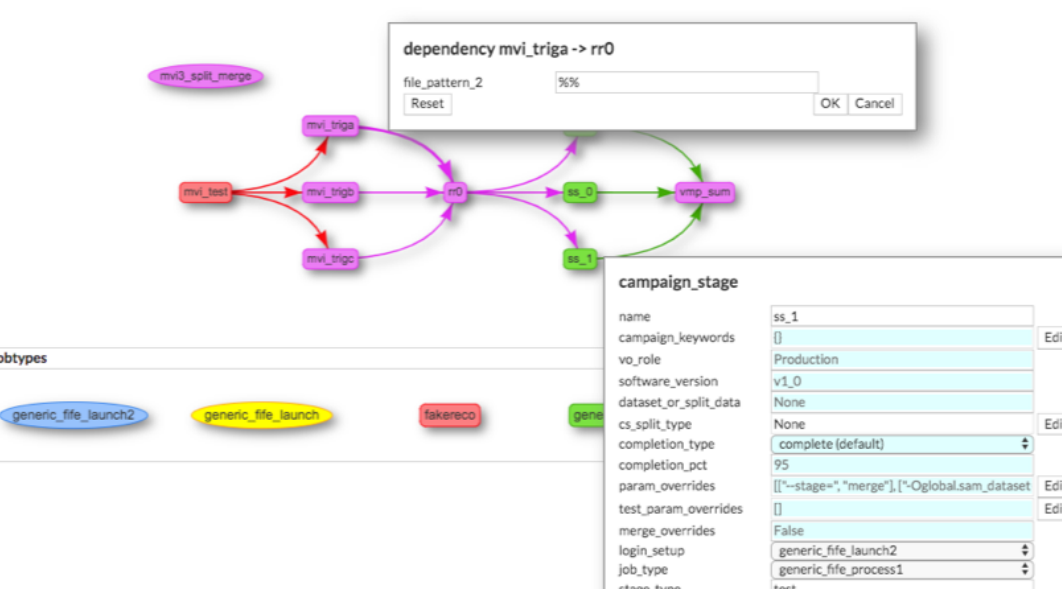
Figure 4. POMS campaign editor screen with a stage opened for